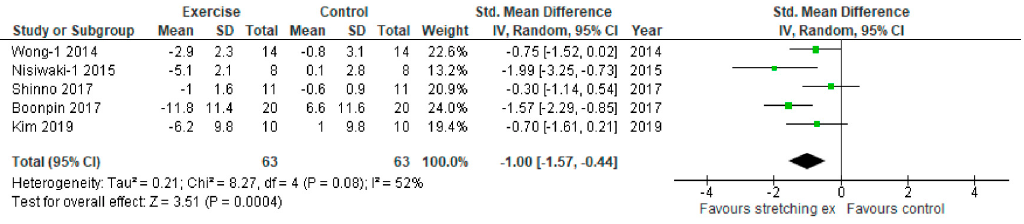
Figure 2. Forest plot comparing changes in arterial stiffness following stretching exercises to non-exercise controls (primary analysis for primary outcome). SD, standard deviation; IV, inverse variance; CI, confidence interval; Std, standardized.